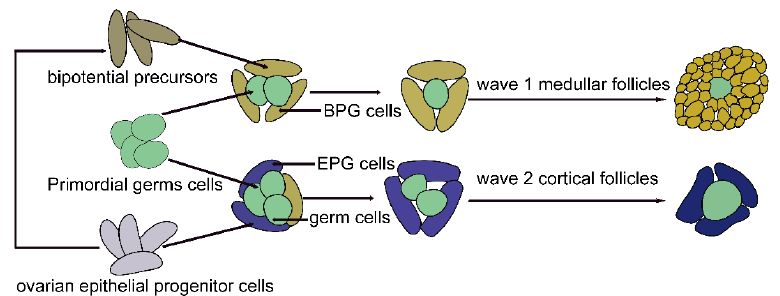
Figure 2. Schematic diagram of the origin and development of pregranulosa cells. BPG cells originate from bipotential precursors, which are derived from ovarian epithelial progenitor cells. BPG cells enclose several primordial germ cells to form germ cell nests. Next, the nest breaks down, and BPG cells differentiate into granulosa cells of wave 1 follicles, which began to develop immediately after birth in the medullar region. Additionally, some BPGs may remain in the cortex for some time. With the development of the embryo, cortical BPG cells are replaced by EPG cells, which do not significantly reside in the ovarian medulla. EPG cells are derived from ovarian epithelial progenitor cells and become the granulosa cells of wave 2 follicles in the ovarian cortex, which represent the ovarian reserve (BPG, bipotential pregranulosa; EPG, epithelial pregranulosa).